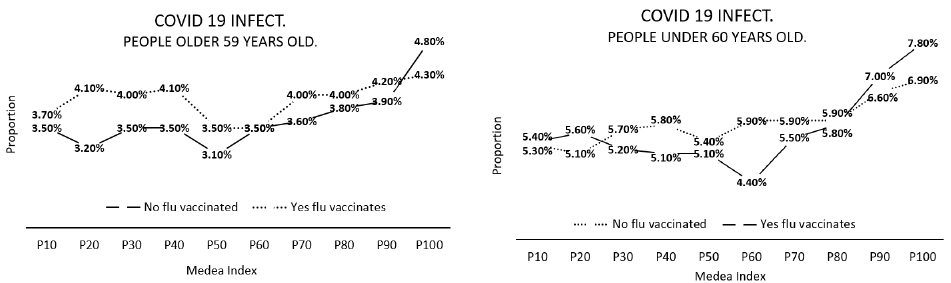
Figure 5. Probability of contracting COVID-19 depending on whether or not a person has been vaccinated against flu, and the size of the MEDEA index. For people above and below 60 years of